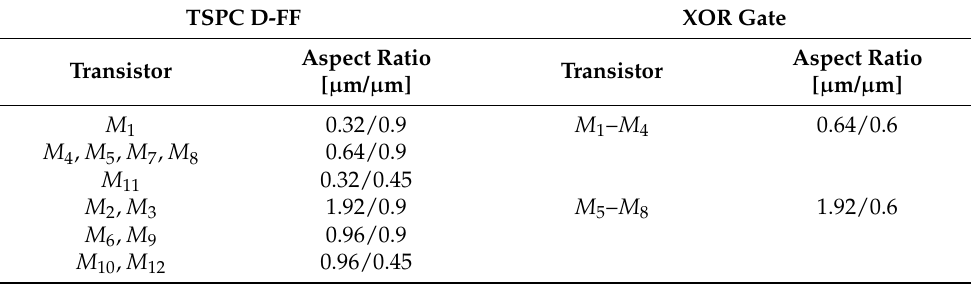
Table 3. Aspect ratios of TSPC D-FF and XOR transistors.